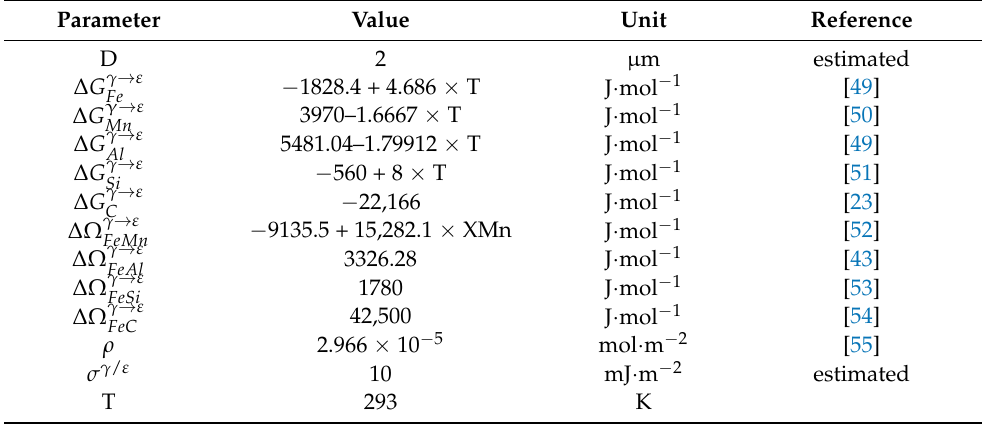
Table A1. The parameters used for modeling SFE: Grain Size D, Gibbs free energy ∆ G γ → ε for each element upon the phase transformation of austenite to martensite, interaction parameters Ω γ → ε , interfacial energy σ γ / ε and temperature